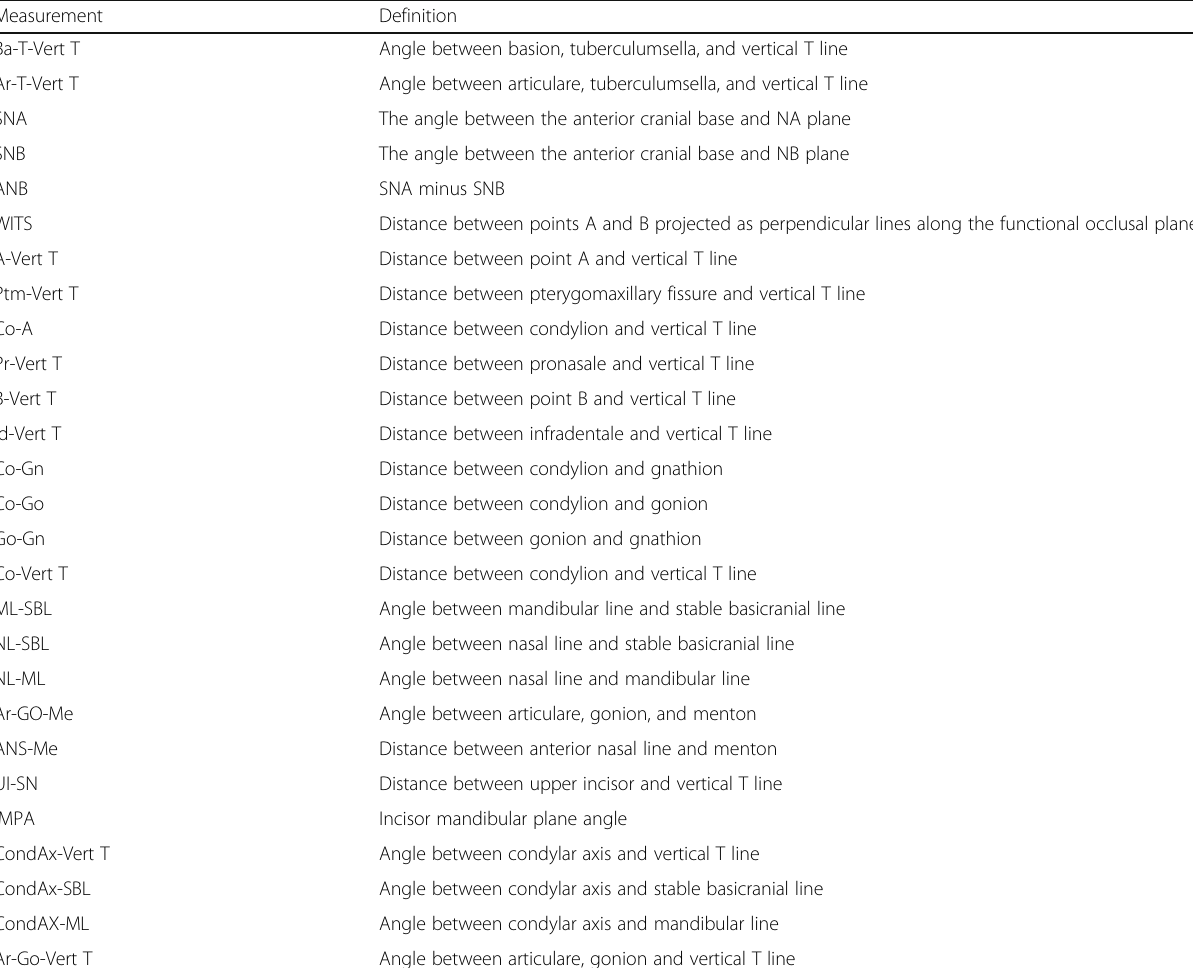
Table 2 Definitions of angular and linear measurements used in this study